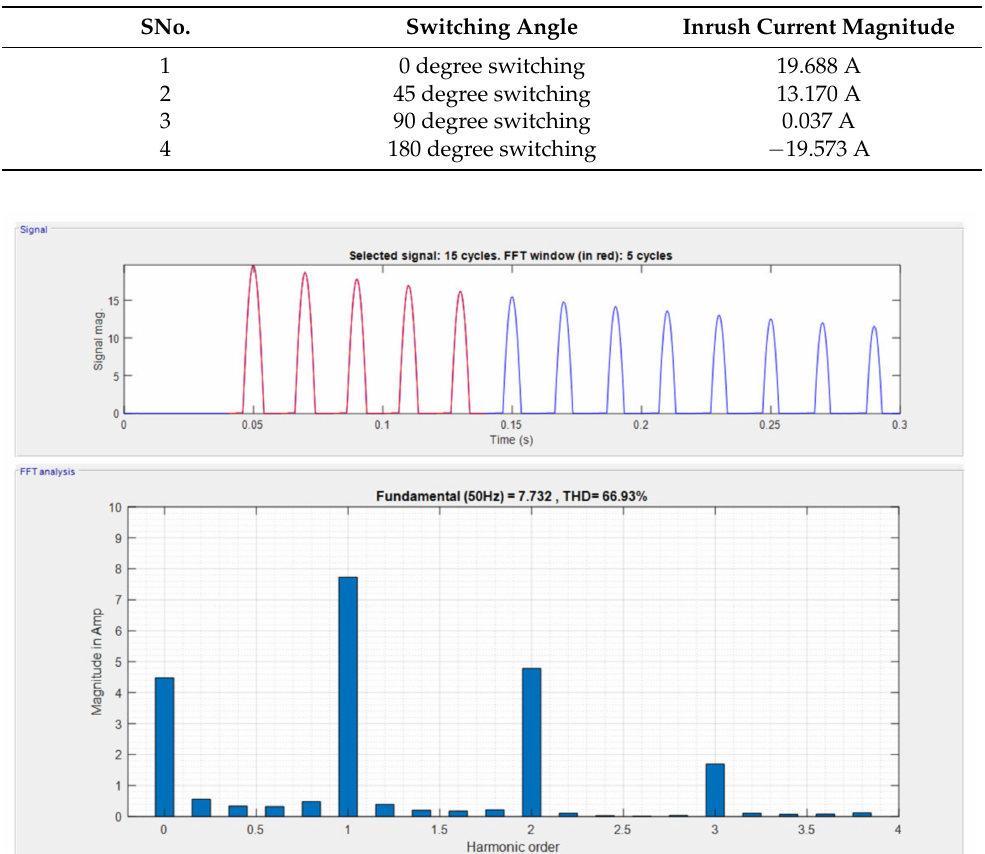
Figure 9. Inrush currents for various switching angles. Table 3. Magnitudes of magnetic inrush current for various switching angles.